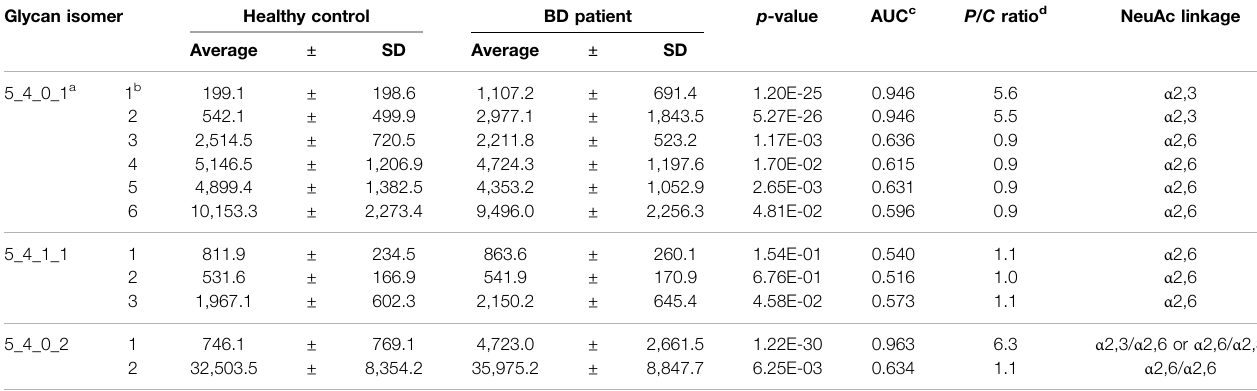
TABLE 1 | The absolute peak abundance and statistical analysis results of identi fi ed sialylated glycan isomers from the sera of healthy control ( n (cid:1) 47) and BD patient ( n (cid:1) 47); average values from technical replicates of each sample were presented. Glycan isomer Healthy control BD patient p